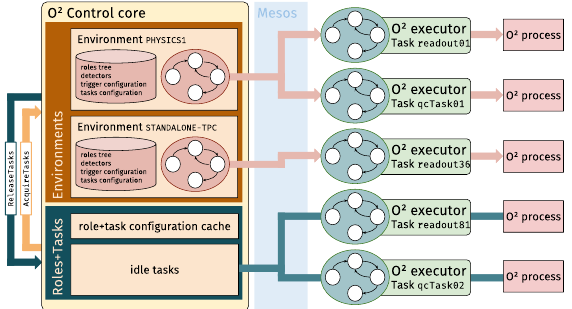
Figure 4. Example of how O 2 control handles task